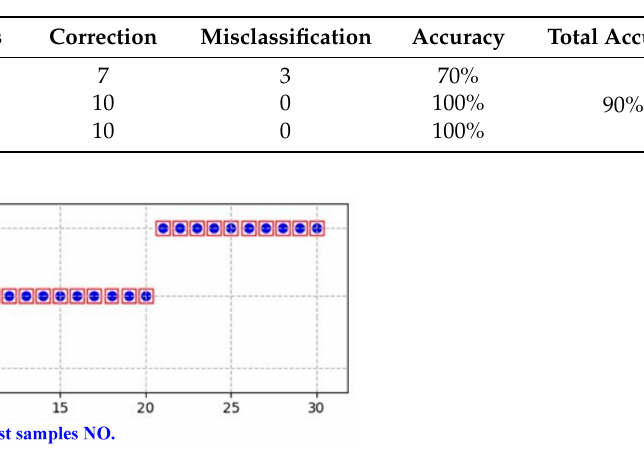
Figure 15. Accuracy distribution map of the SVM model under different super-parameter combinations. Table 2. Statistical table of the classification results using the test sets.